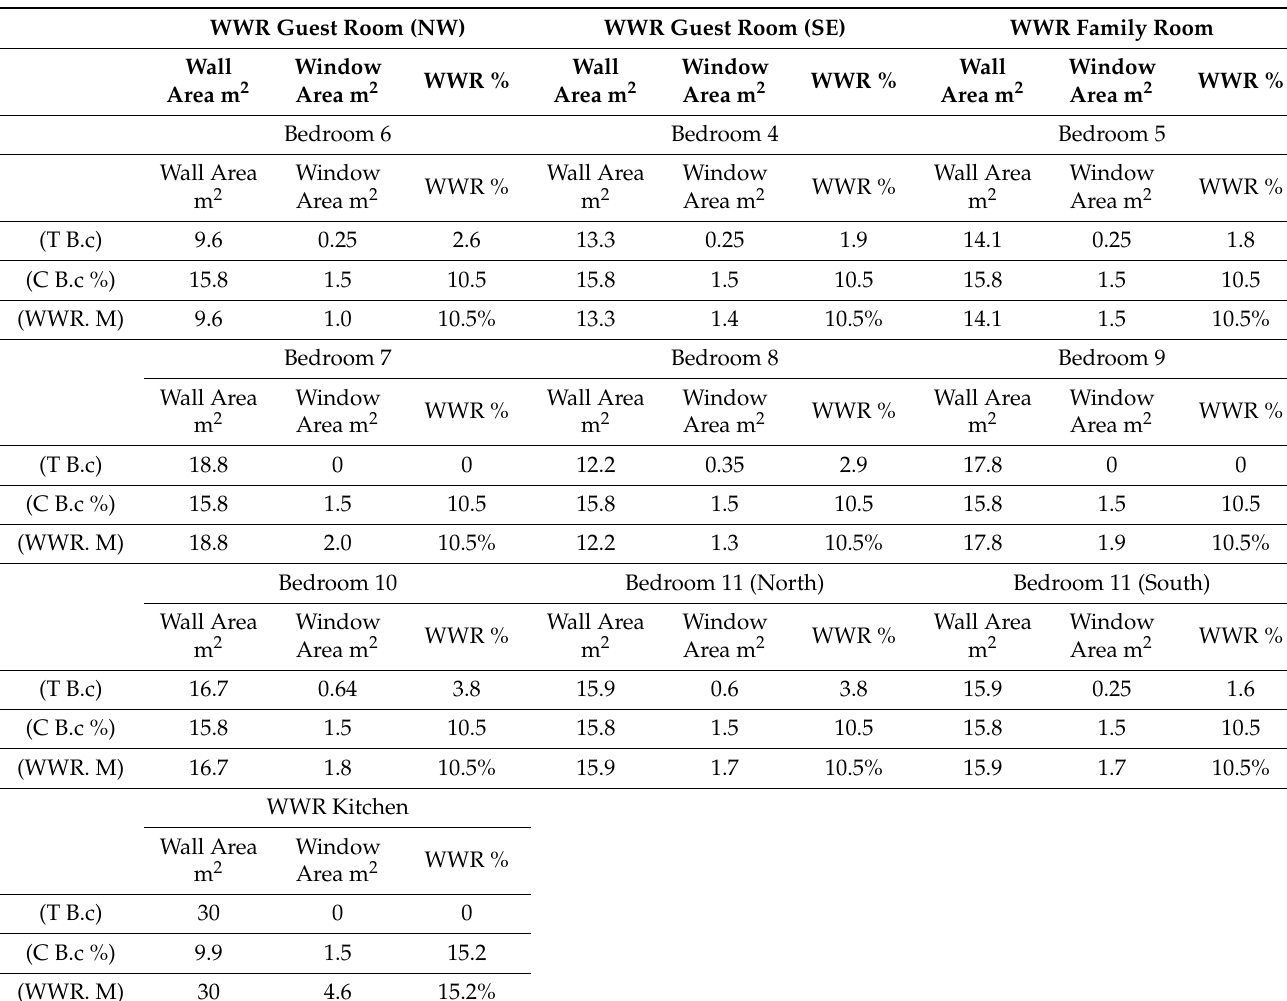
be considered: green areas, traffic conditions, zoning, size, topography, and